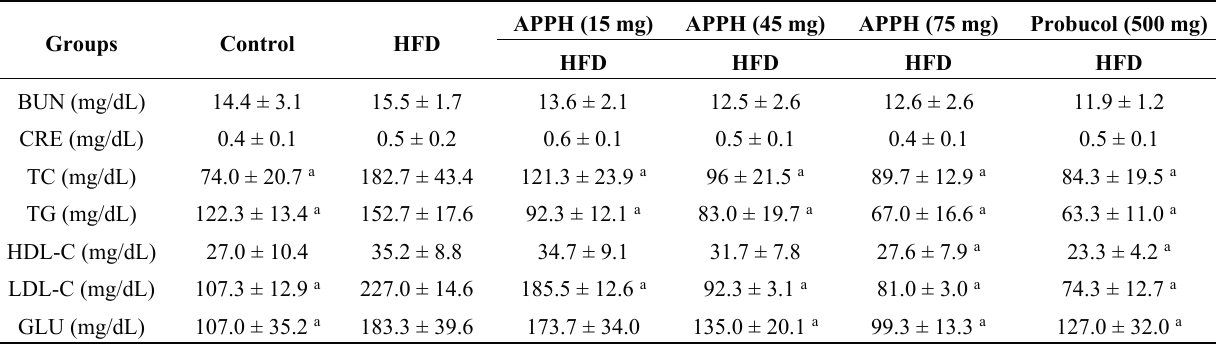
Table 1. Serum biochemical